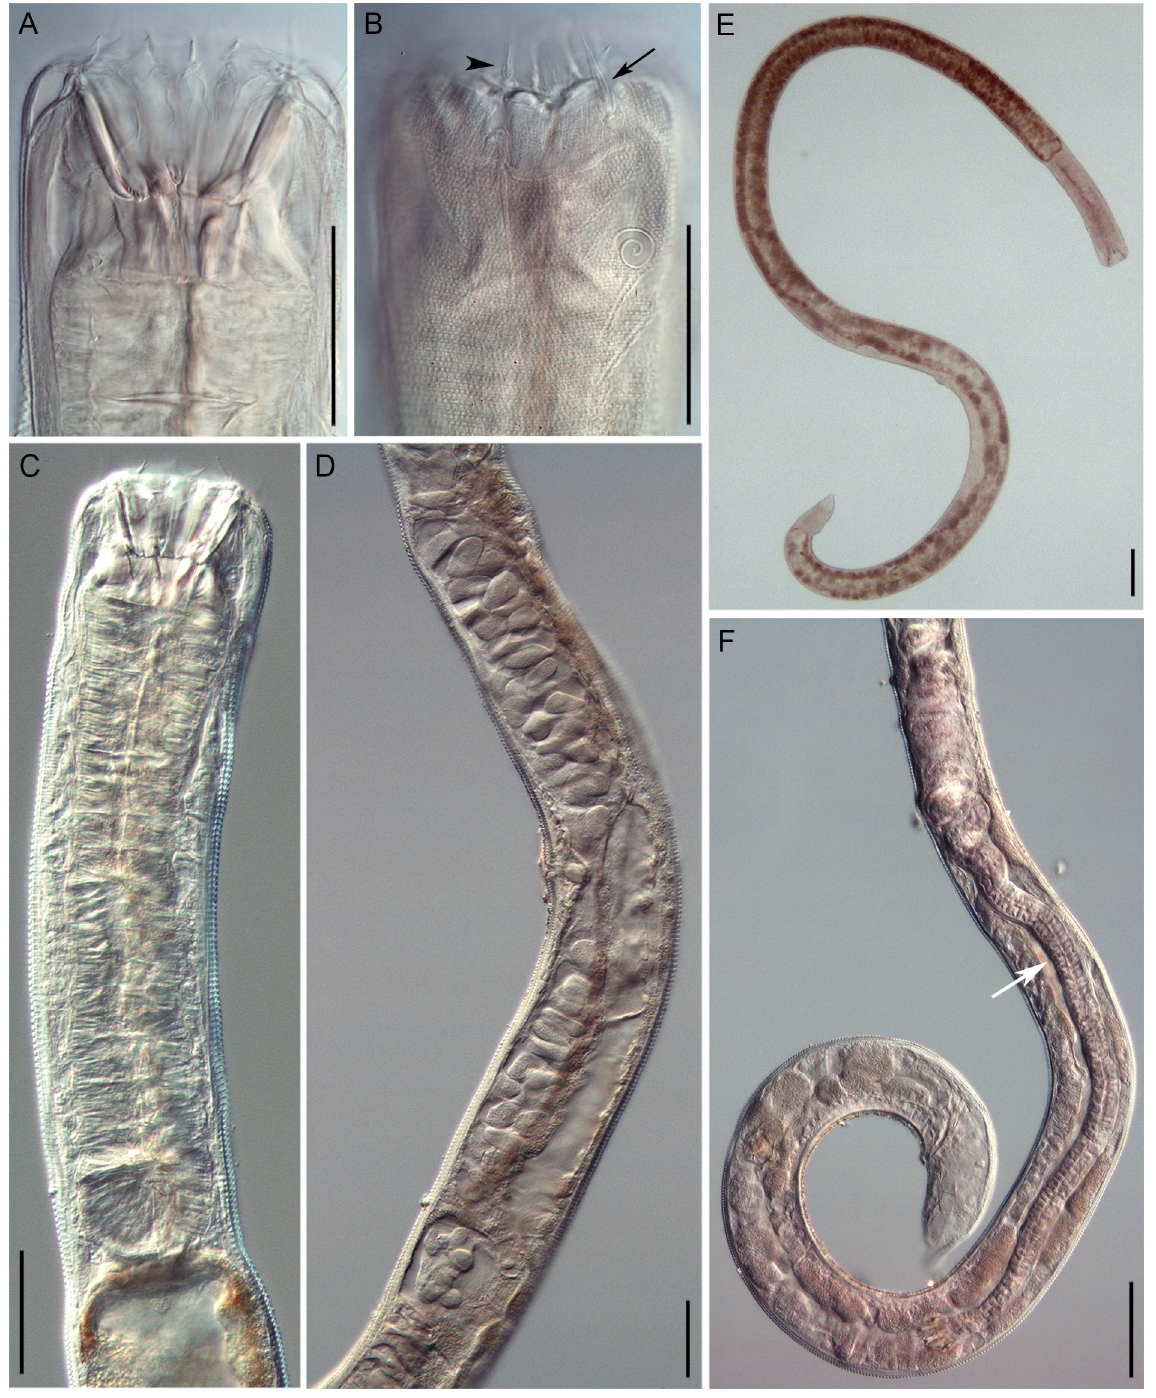
Fig. 4. Gammanema magnum sp. nov., paratype, ♀. A–B . Head, showing the small multispiral amphideal fovea, the leaf-like inner (arrowhead) and outer (black arrow) labial setae, the transverse rows of punctuations, and the buccal cavity as drawn in Fig. 2. C . Anterior region, showing the cylindrical pharynx surrounded by numerous cells, with anterior end swelling but not forming a bulb. D . Large spermatheca with globular to oval sperm cells. E . Overview, showing the slender body and conical tail. F . The intestine contains a prey nematode, likely a member of Epacanthion Wieser, 1953 (white arrow). Scale bars: 50